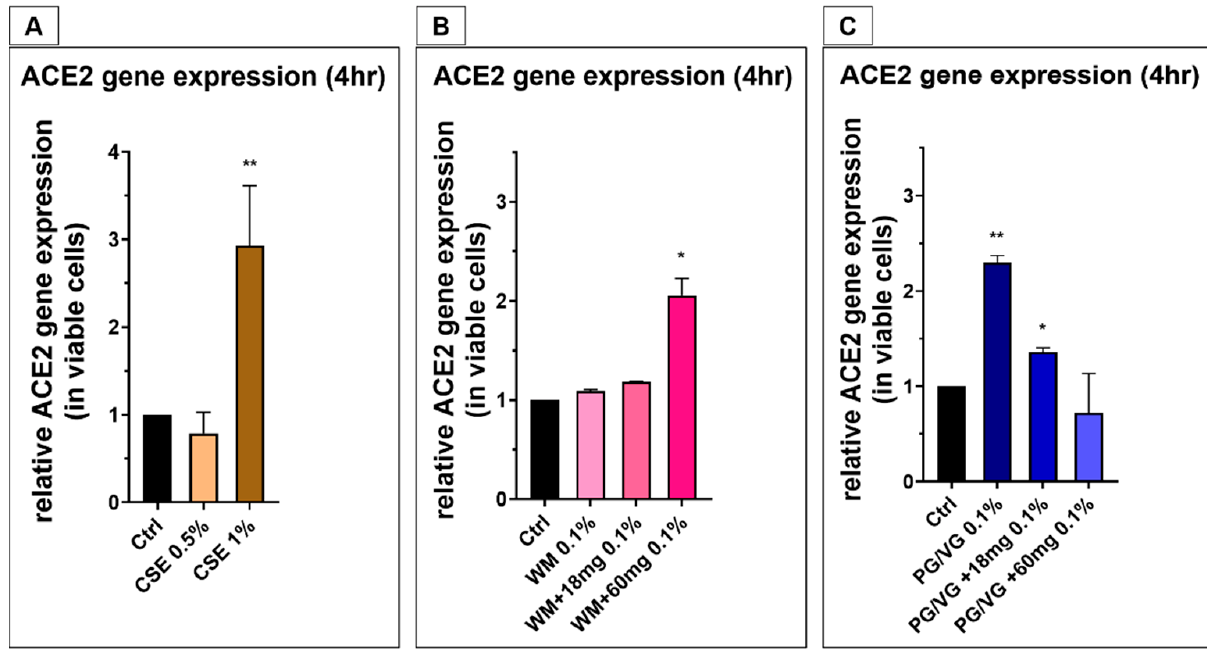
Figure 8. Angiotensin-converting enzyme-2 (ACE2) mRNA expression in BEAS-2B cells following cigarette smoke exposure and electronic cigarette condensates: BEAS-2B cells were exposed to ( A ) cigarette smoke extract (0.5% and 1%) or 0.1% concentration of electronic cigarette condensate generated from ( B ) watermelon-flavored e-liquid (Juicius Maximus) or ( C ) PG/VG ± nicotine for 4 h. Gene expression for ACE2 was assessed in treated cells and is presented as relative gene expression over cell controls, normalized with cytotoxicity for each treatment. Data are displayed as a median and interquartile range of n = 3–4 independent experiments. Nonparametric Mann–Whitney test was performed. ** p < 0.005, * p <